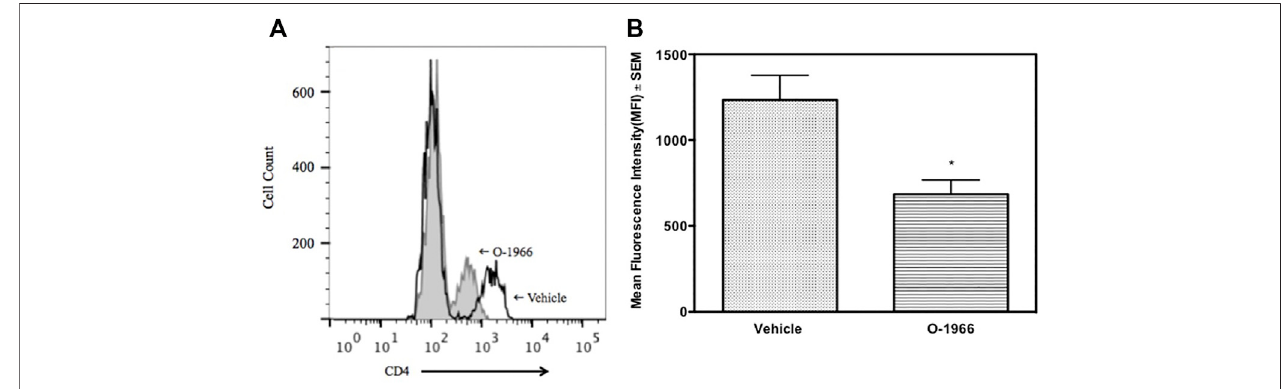
FIGURE 6 | In vivo O-1966 treatment decreases CD4 expression following ex vivo stimulation. Donor C3HeB/FeJ fl ank skin was transplanted to the back of recipient C57BL/6J mice, sutured, and bandaged. Doses of O-1966 (5 mg/kg) or vehicle (0.03% ethanol and 0.03% cremophor in saline) were injected i.p. every other day from 1 h pre-op to 14 days post-op. On post-op day 14, animals were sacri fi ced and spleens were aseptically removed, restimulated with C3HeB/FeJ splenocytes and harvested at 48 h and analyzed by fl ow cytometry for CD4 expression. (A) Representative histogram of CD4 expression on CD3 + cells in cultures of splenocytes from skin graft recipient mice treated with O-1966 (gray fi lled) or vehicle (white fi lled). (B) Mean fl uorescence intensity (MFI) of CD4 in CD3 + populations in cultures from O-1966 treated mice ( ) or vehicle treated mice ( ) . Data are representativeof two experiments (A) or mean of two separate experiments (B) . * p < 0.05 for O-1966 vs. vehicle by one-way ANOVA followed by Tukey ’ s multiple comparison test).